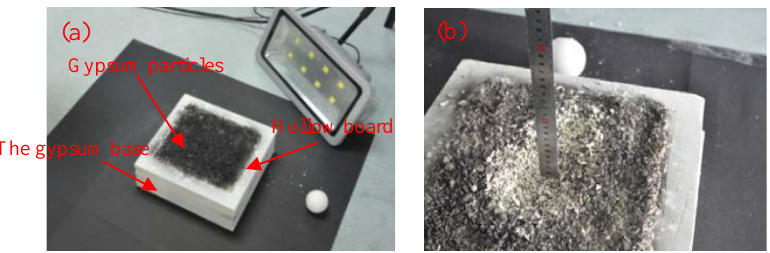
Figure 4. Photographs of a cushion (a) before and (b) after a rock impact